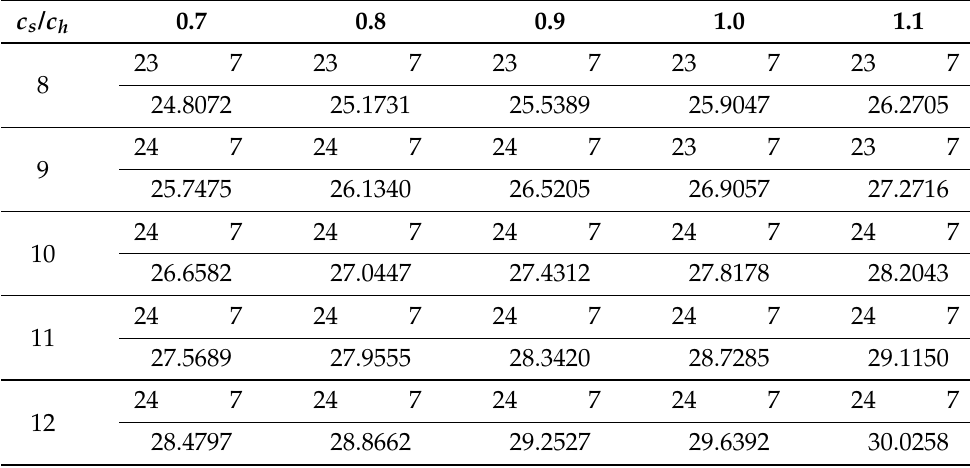
Table 4. Ramification of the cost of setup cost ( c s ) and holding cost ( c h ) on the optimal